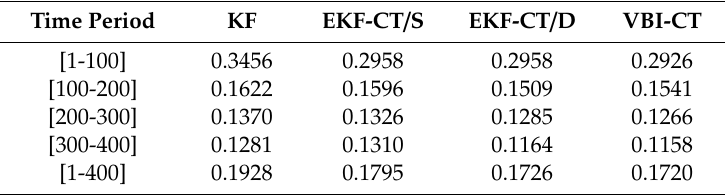
Table 4. Comparison of tracking error of di ff erent algorithms with σ 2 =